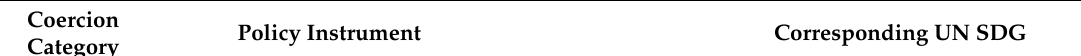
Table 2. The green infrastructure policy landscape in Ontario,